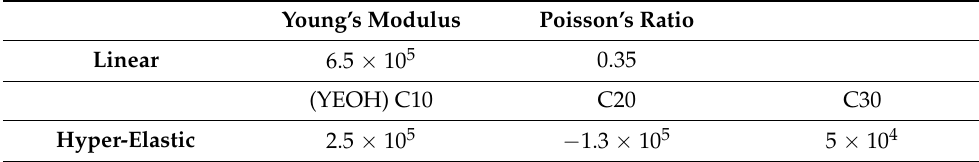
Table 2. Parameters for membrane